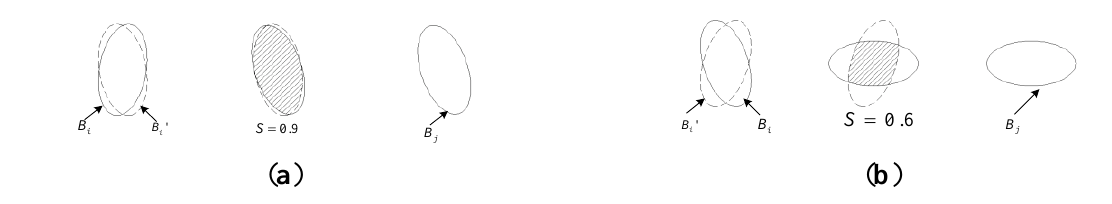
Figure 4. Examples of symmetry of two spots: ( a ) Symmetry of taillights in the same; ( b ) Symmetry of taillights in different.